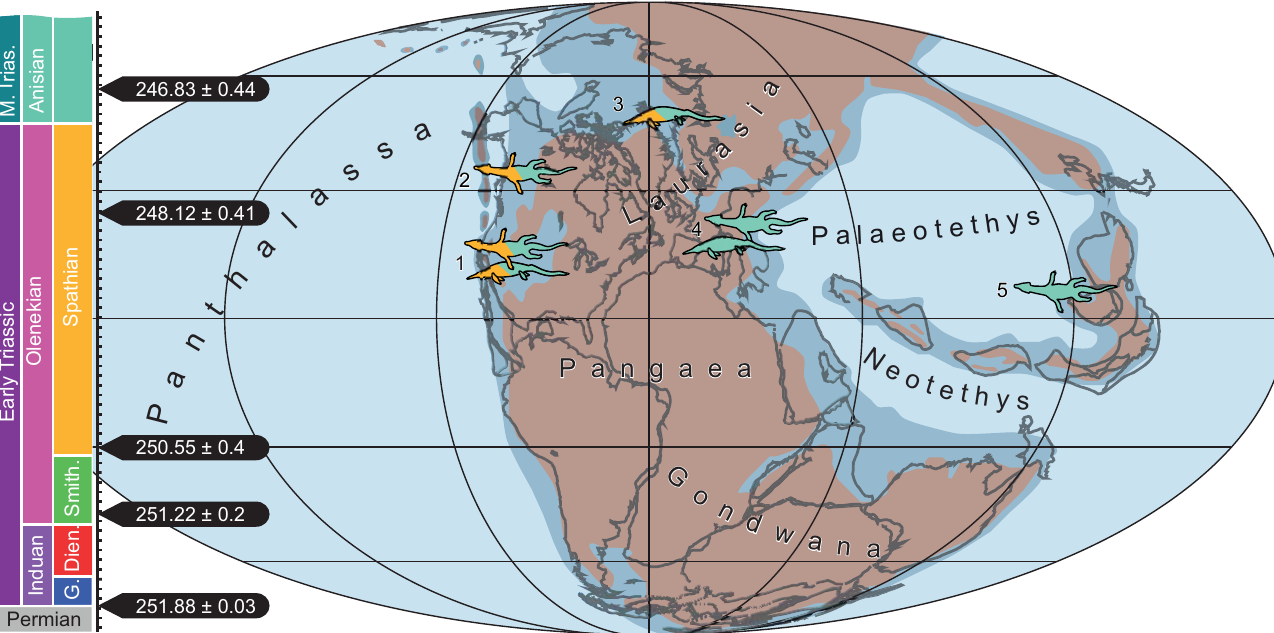
Fig. 3. Early Triassic map showing occurrences of Early Triassic (Olenekian) and Middle Triassic (Anisian) with potential apex predators in the respec- tive marine ecosystems. Larger Eosauropterygia are represented by a nothosaur-shape and larger Ichthyopterygia by an ichthyosaur-shape. 1, Nevada and Idaho, USA: ichthyopterygian Thalattoarchon (Anisian), “ Cymbospondylus ”-like, shastasaur-like ichthyopterygians and Cymbospondylus spp. (Smithian/Spathian–Anisian); 2, British Columbia, Canada: Sauropterygia cf. Nothosauroidea indet. (TMP 1995.116.0023)